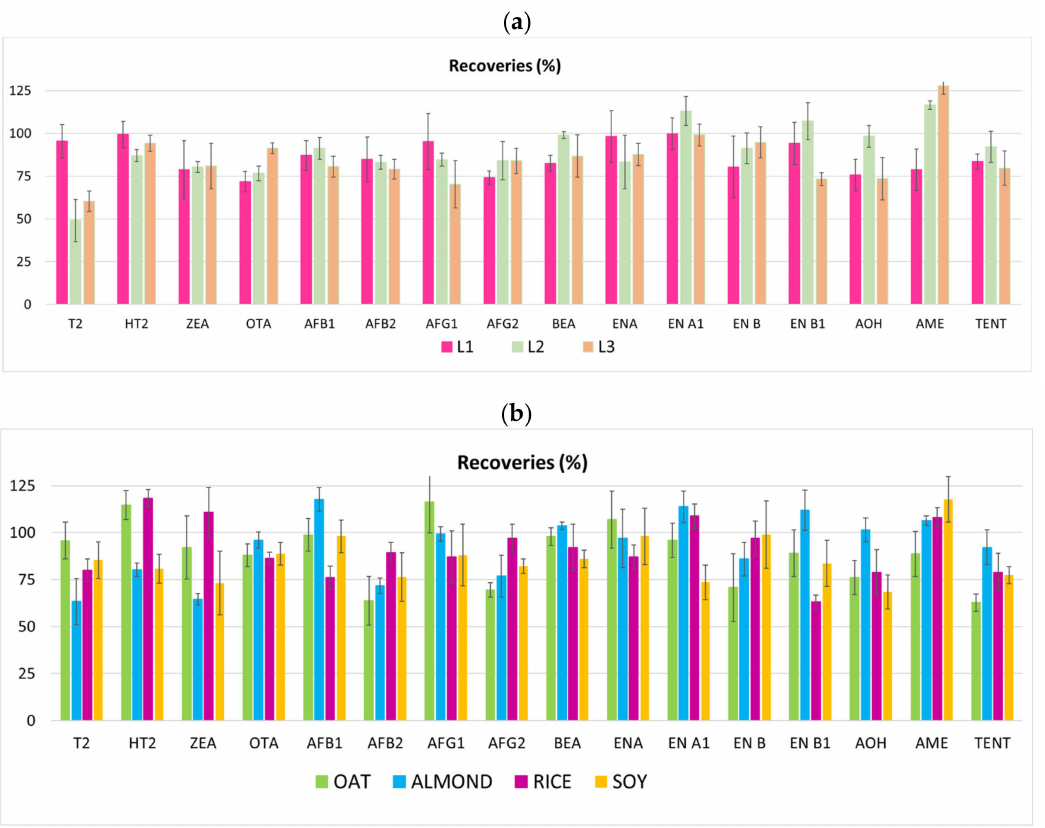
Figure 4. Reproducibility results: ( a ) average reproducibility results (n = 9) of the four matrices at the three levels studied (L1, L2 and L3); ( b ) recoveries obtained from the reproducibility study (n = 9) at the L1 level for the four